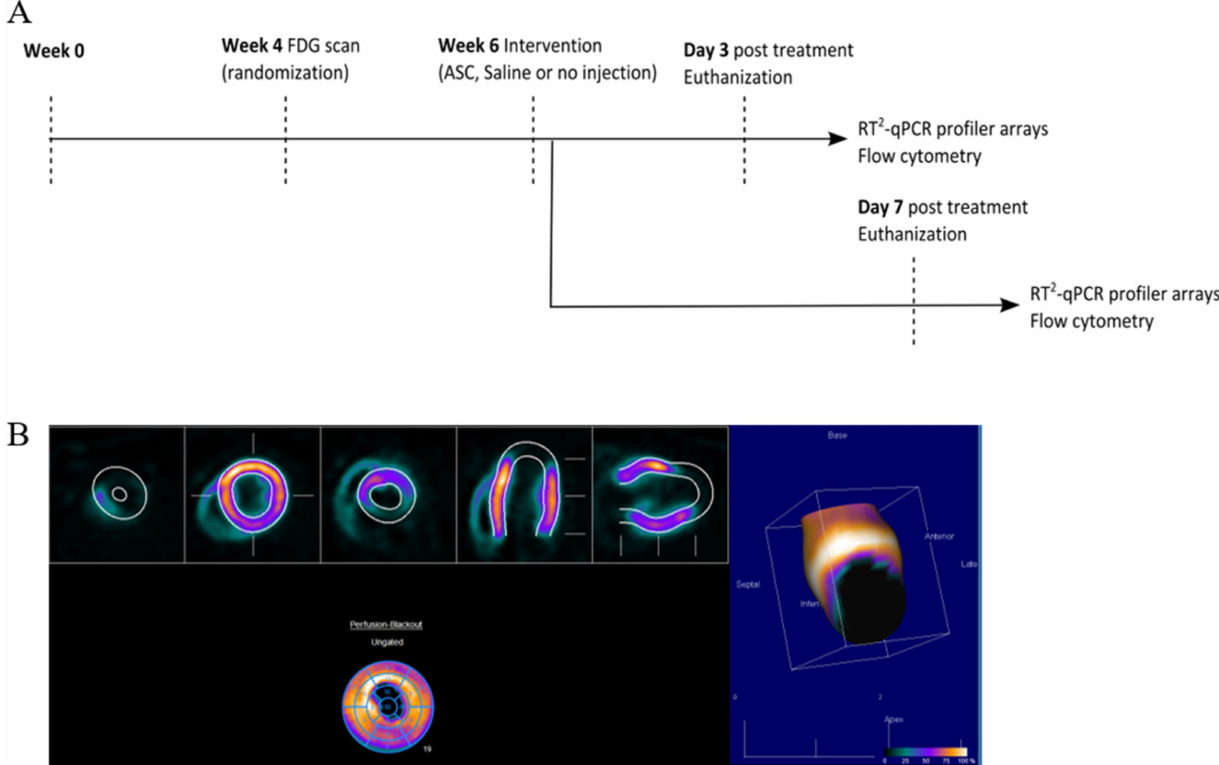
Figure 2. Study design and analysis of cardiac cell composition. ( A ) Study outline. ( B ) FDG PET/CT imaging quantification for infarct